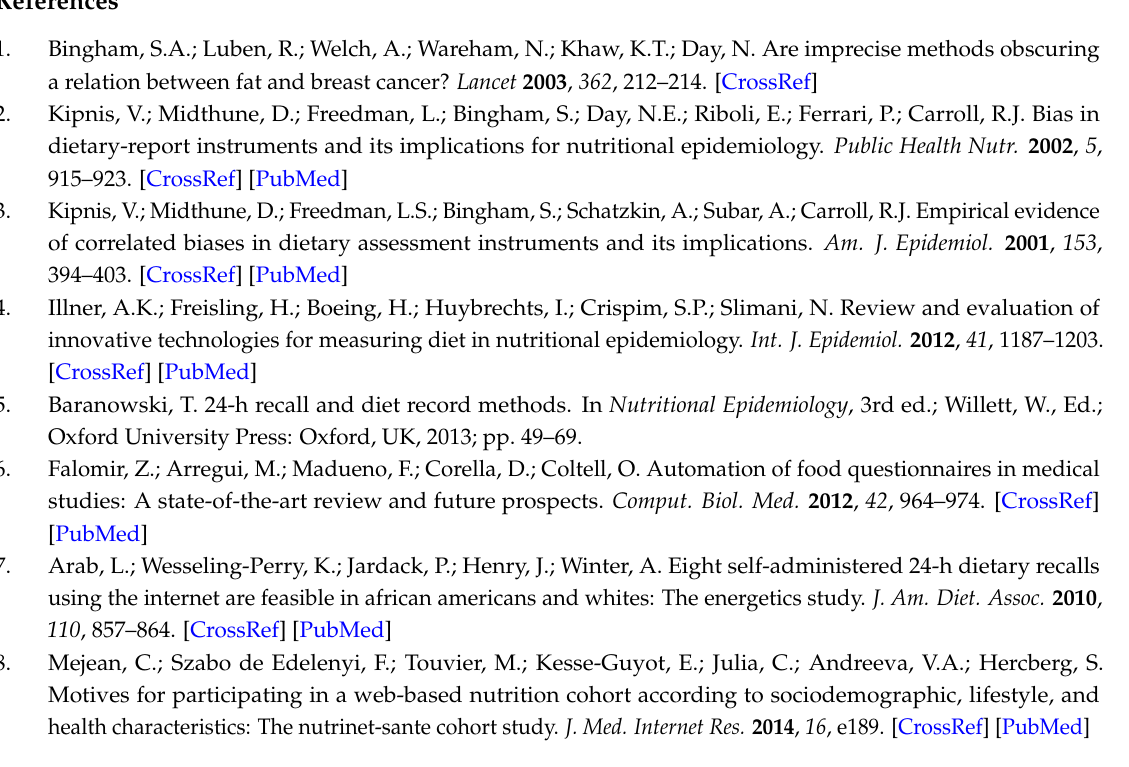
Table S1: Distribution of the 2865 food items in the web-based 24-h recall (R24W). Acknowledgments: This research was supported by a grant of from the Canadian Institutes of Health Research (FHG